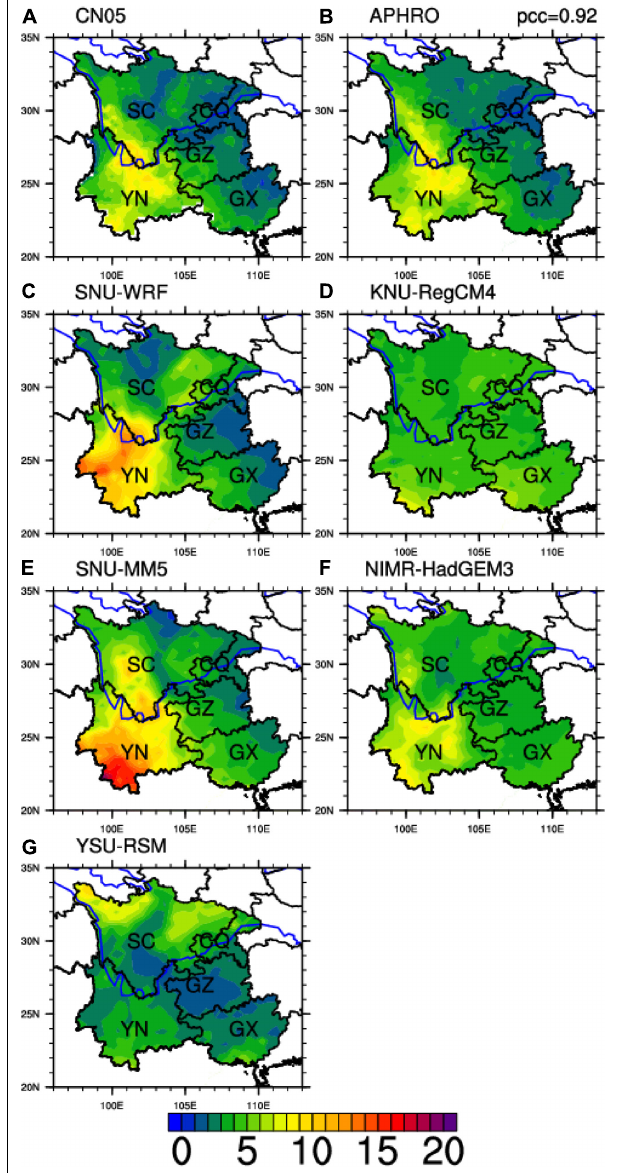
FIGURE 10 | Spatial distributions of the GEV scale parameter of the AMDSL. (A) CN05, (B) APHRO, and five RCMs: (C) SNU-WRF, (D) KNU-RegCM4, (E) SNU-MM5, (F) NIMR-HadGEM3, and (G) YSM-RSM.